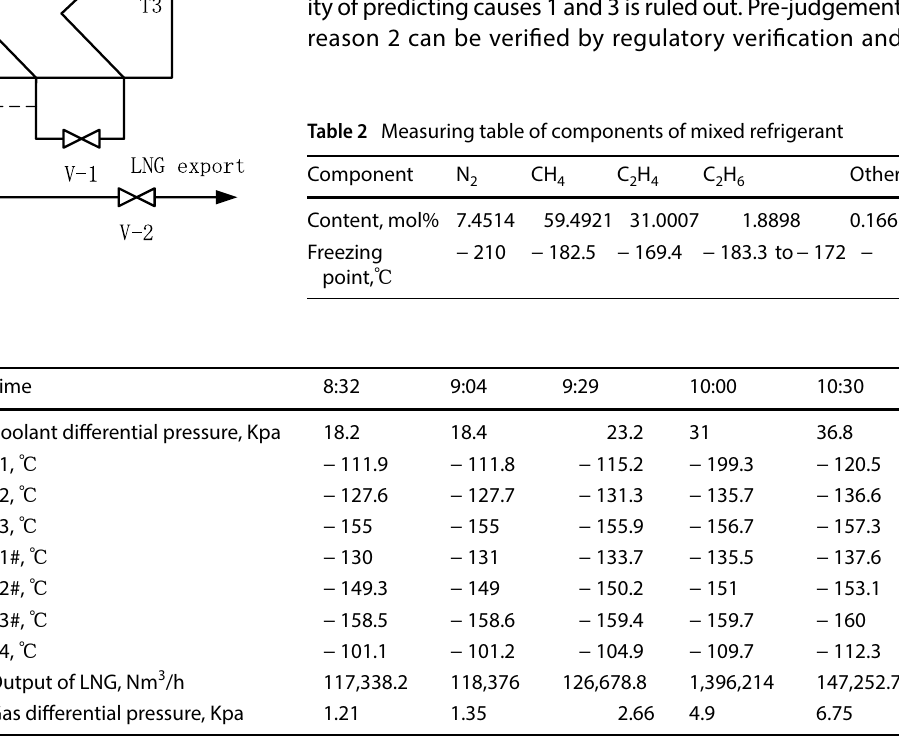
Table 2 Measuring table of components of mixed